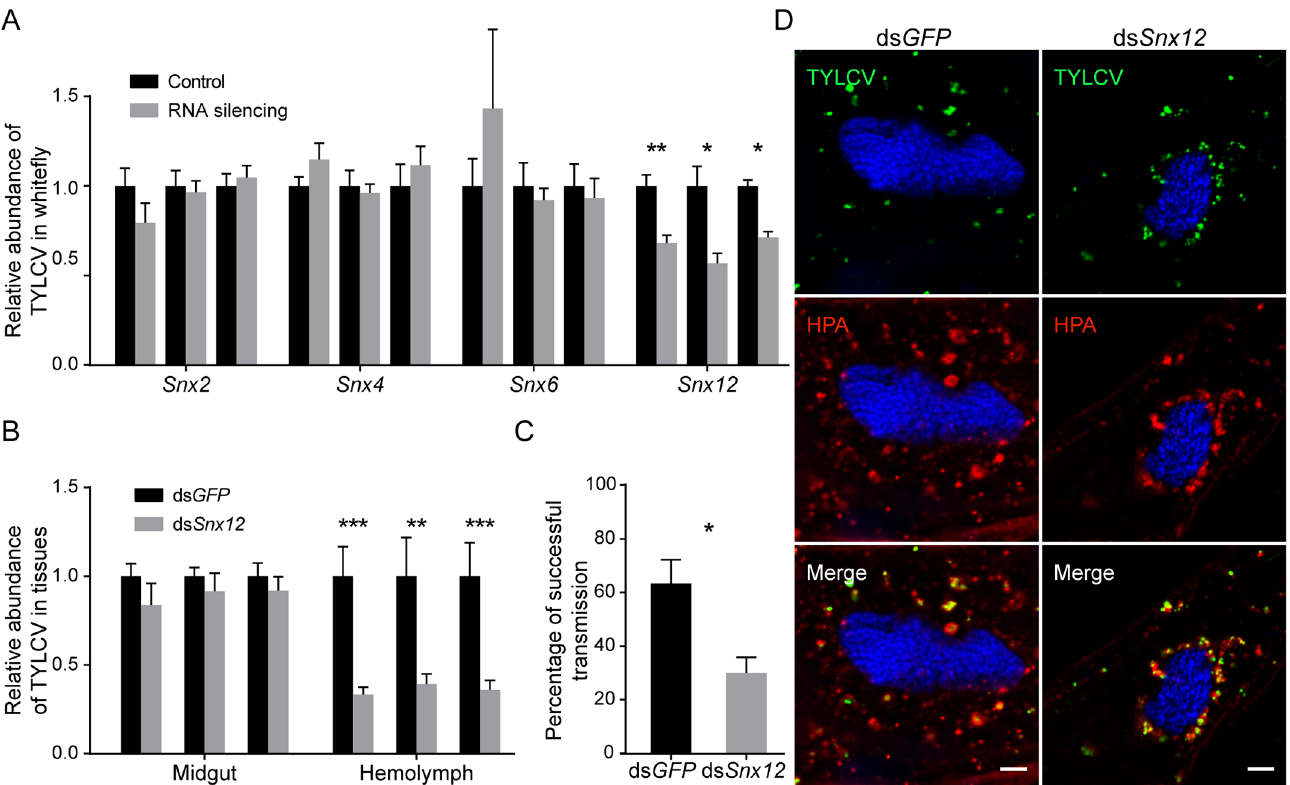
Fig 10. Silencing sorting nexins inhibits TYLCV trafficking. (A-B) Gene silencing of sorting nexins inhibited TYLCV acquisition. After gene silencing by dsRNA injection, whiteflies were transferred to TYLCV-infected plants for virus acquisition. The abundance of virus in the whitefly whole body (A) and in the midgut and hemolymph (B) were measured after 48 h by quantitative PCR and compared with that in controls injected with dsRNA of GFP (for the whitefly whole body n = 4–8; for midgut n = 4; for hemolymph, n = 10–24). (C) Silencing sorting nexins inhibited TYLCV transmission. After dsRNA silencing and 12 h virus acquisition, whiteflies were allowed to feed on tomato seedlings for 48 h and then removed. Percentages of tomato plants infected by the virus were calculated (n = 30). (D) Silencing sorting nexins led to perinuclear distribution of HPA-labeled vesicles. Three days after dsRNA injection, whiteflies were allowed to feed on TYLCV-infected plants for three days and prepared for immunostaining. Colocalization between TYLCV and HPA in whiteflies injected with dsRNA of Snx12 or GFP was quantified as 0.47 ± 0.02 and 0.48 ± 0.03, respectively (Pearson’s coefficient, mean ± SE, n = 14–15). Scale bar, 5 μ m. Representative images that were used to generate the data are provided in S10 Fig. Data shown are mean ± SE. Statistically significant differences are indicated as: (cid:3) , P < 0.05; (cid:3)(cid:3) , P < 0.01; (cid:3)(cid:3)(cid:3) , P <